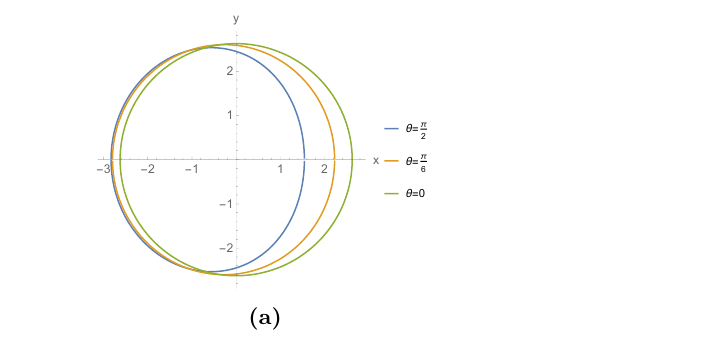
Figure 5. (a) Shadow of a BH in AdS space with parameters ‘ = 3, M = 1, a = 0 : 7, Q = 0 : 3